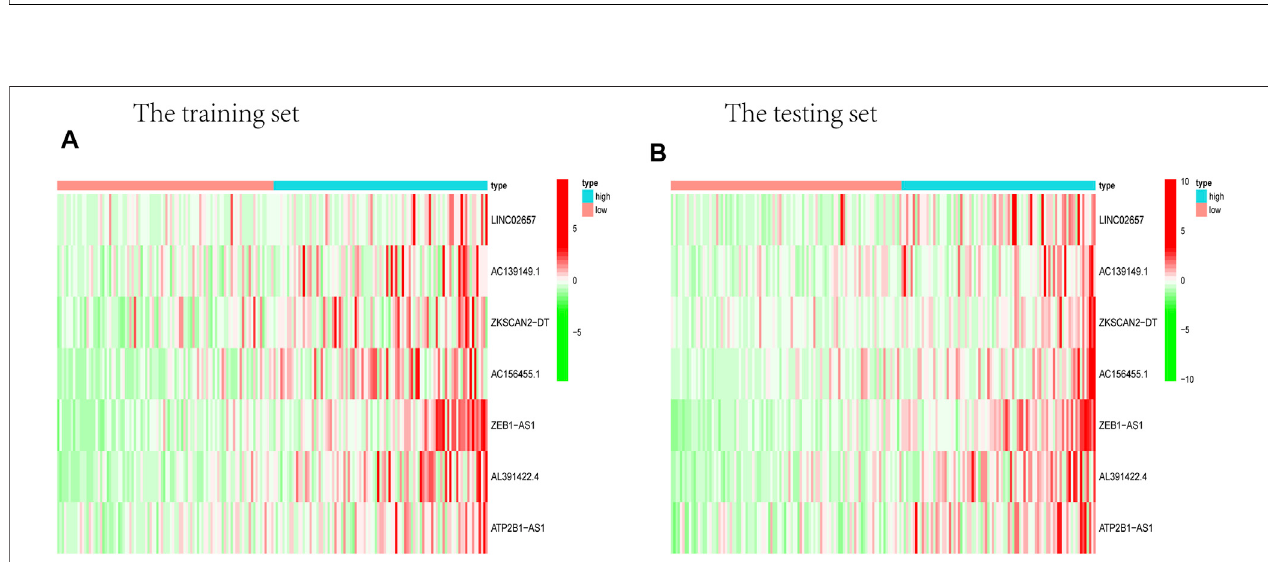
FIGURE 5 | Heat map about the expression of m6A-related prognostic lncRNAs. (A) Training group. (B) Testing group. ZEB1-AS1 was signi fi cantly higher in both testing and training high-risk groups than low-risk ones.